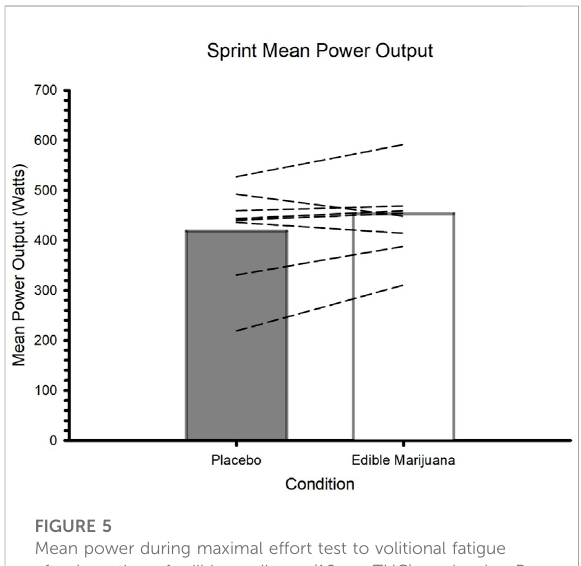
FIGURE 5 Mean power during maximal effort test to volitional fatigue after ingestion of edible marijuana (10 mg THC) or placebo. Bars represent mean data; dashed lines represent individual responses. p =